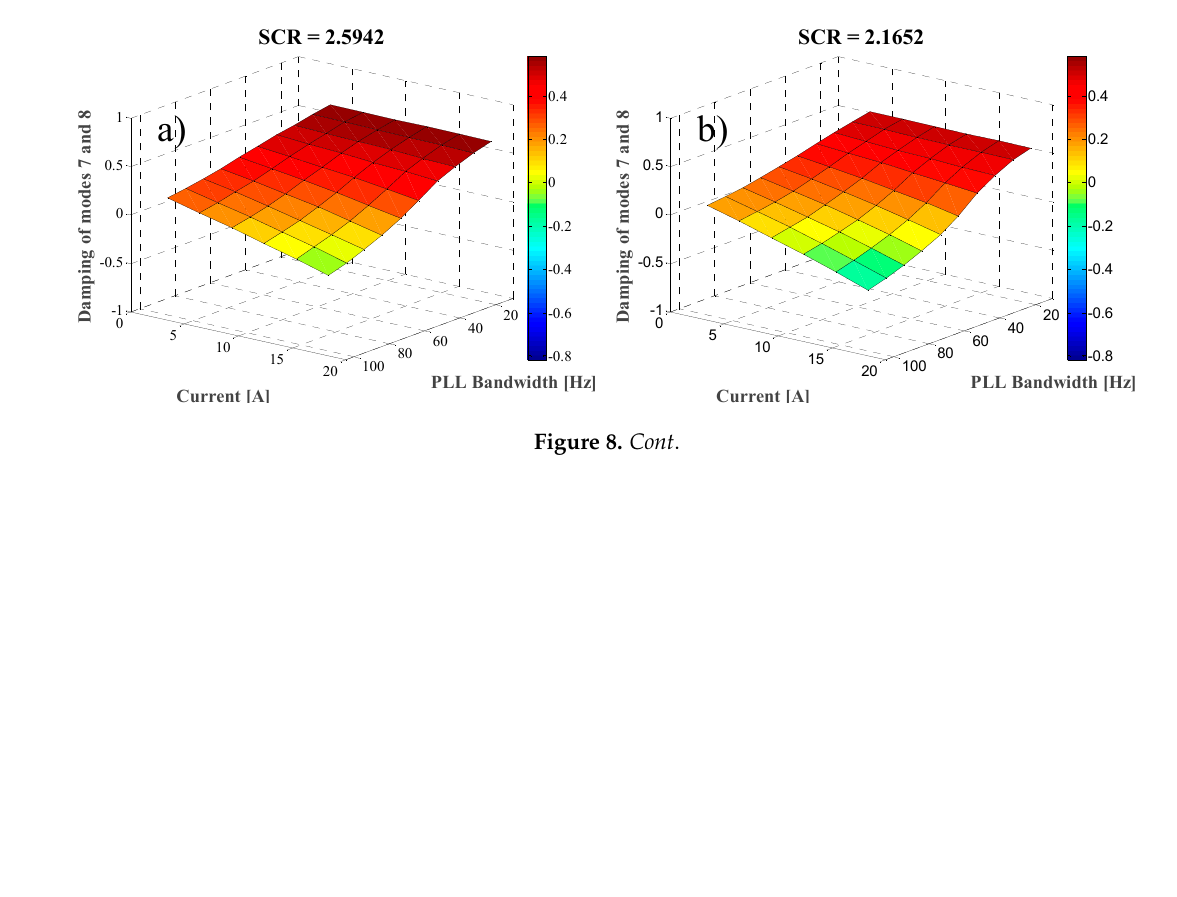
Figure 7. Damping of modes of the proposed small signal model as a function of the PLL bandwidth and the following short circuit ratios (SCR) of the weak grid: ( a ) SCR = 2.5942; ( b ) SCR = 2.1652; ( c ) SCR = 1.8577; ( d ) SCR = 1.6265.